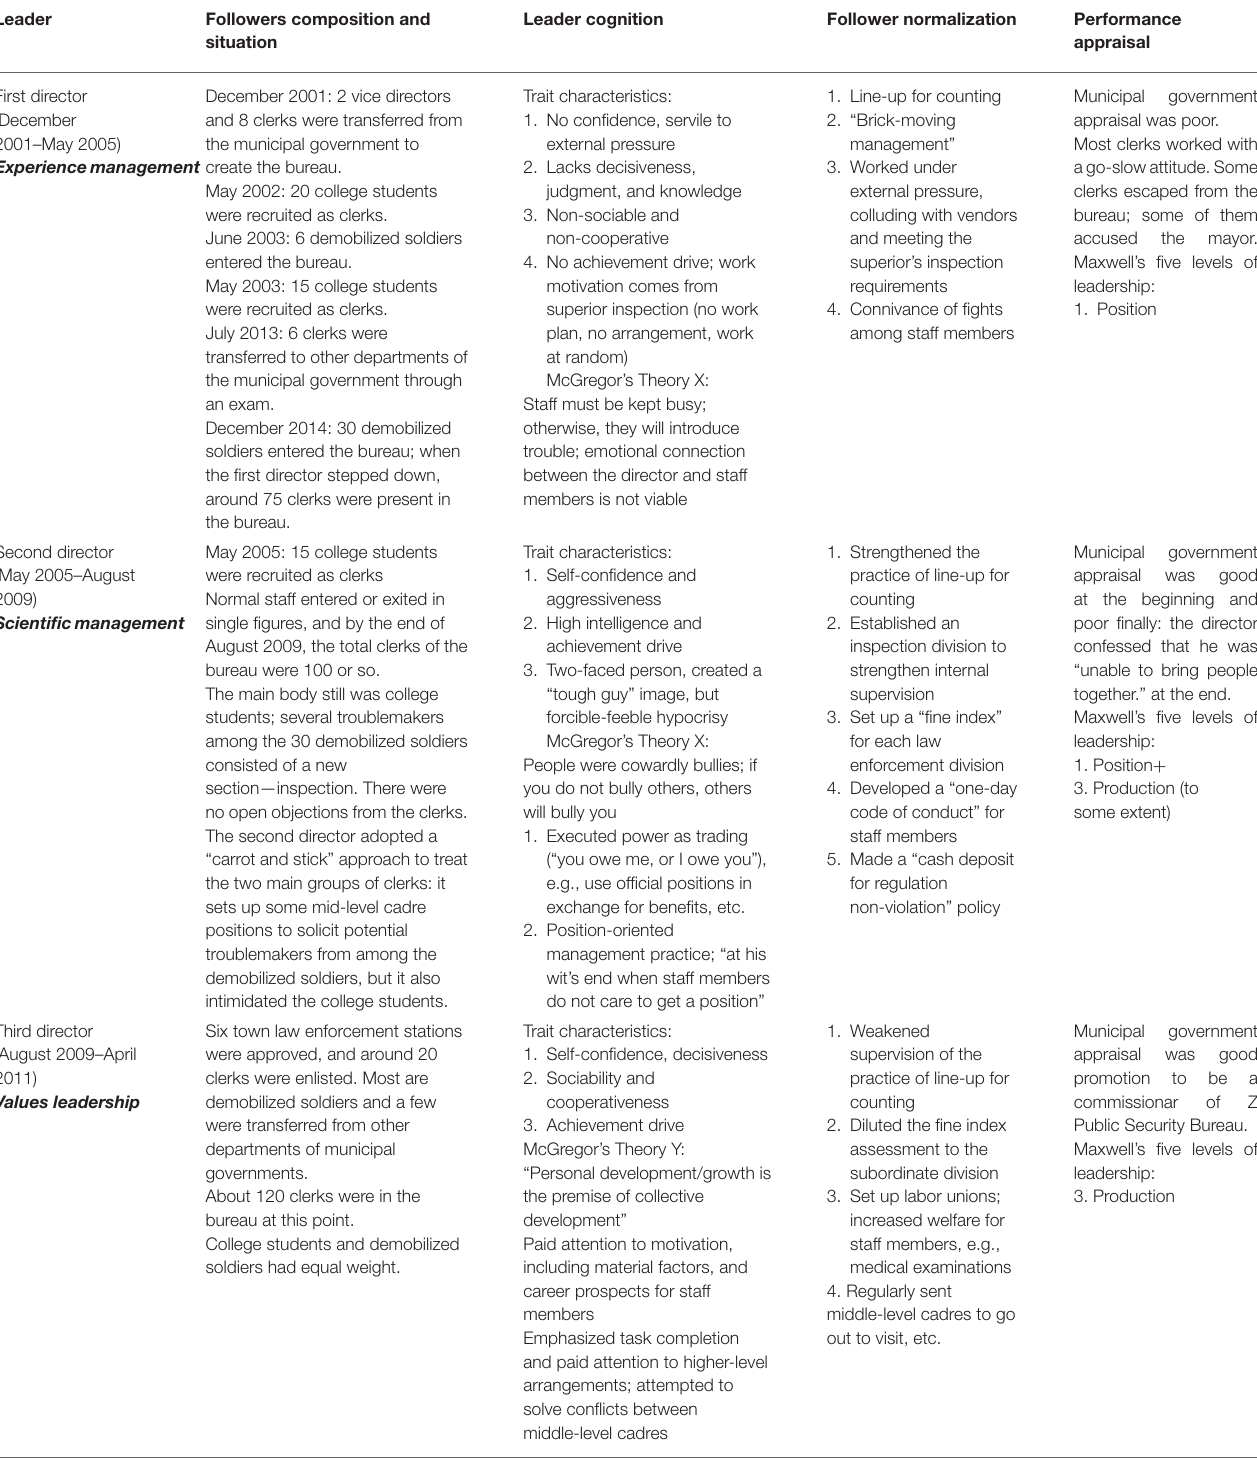
TABLE 2 | Analysis of the leadership, practices, and work performance of the seven directors.